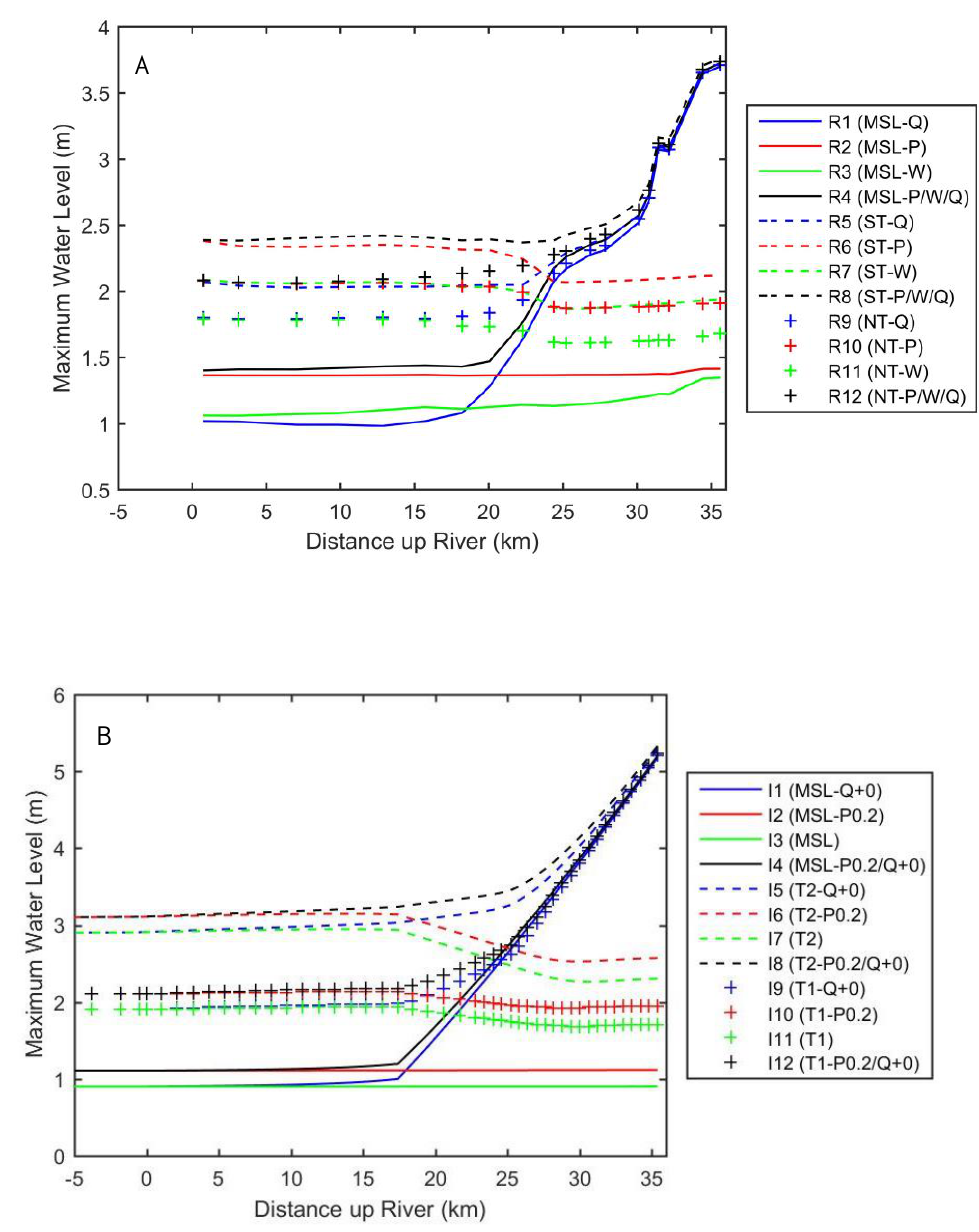
Figure 5. Maximum water level along river during a storm for ( A ) realistic and ( B ) idealized storms.